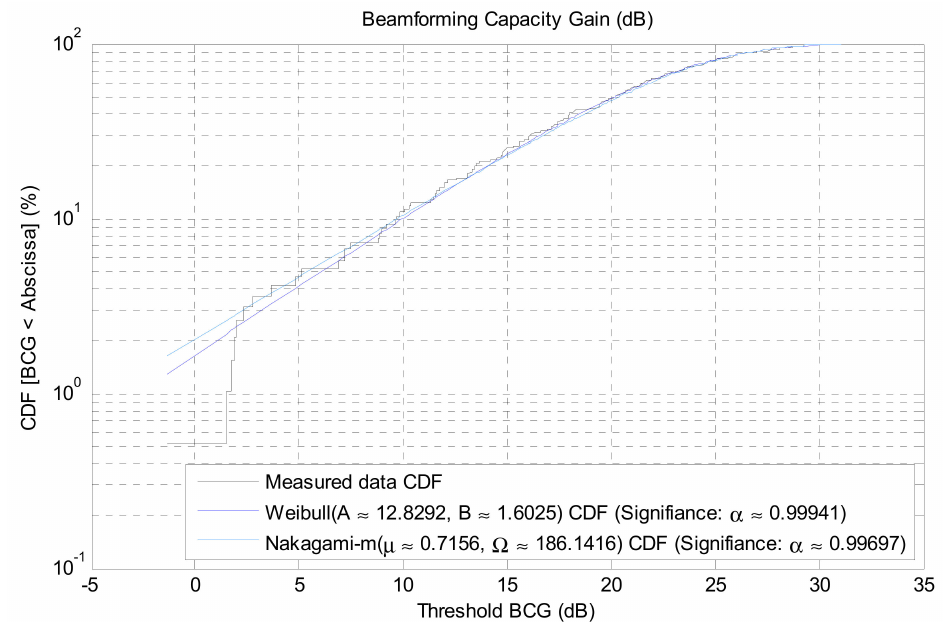
Figure 5. Cumulative distribution function (CDF) of the 5G beamforming capacity gain measured using an EMITE H300 anechoic